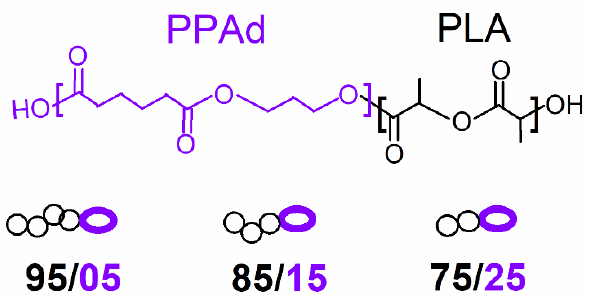
Figure 1. Chemical structure of PPAd and PLA diblock copolymers under investigation.